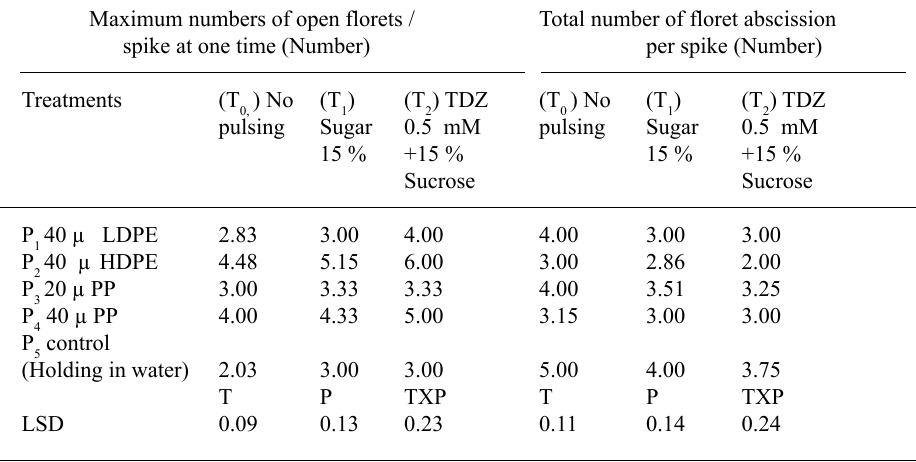
Table 3. Effect of pre-storage pulsing and packaging films on maximum numbers of floret open